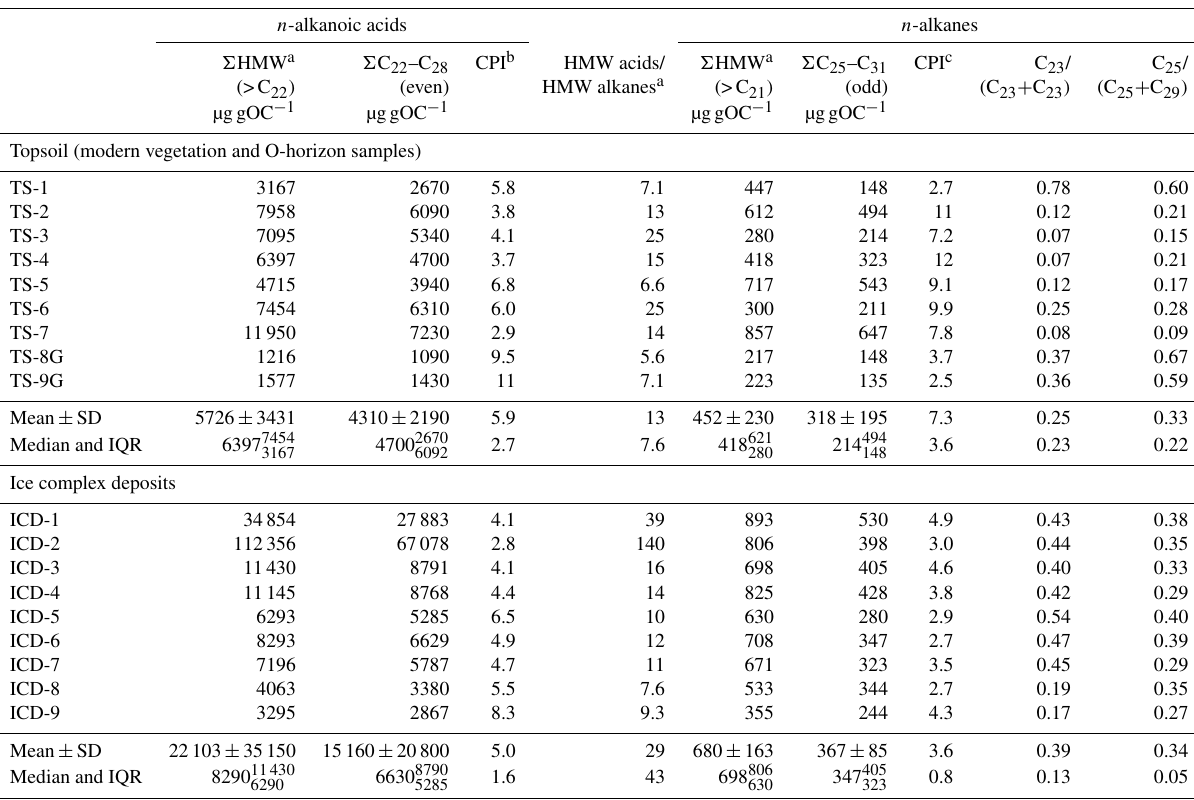
Table 4. Sum of most abundant long-chain n -alkanoic acids and n -alkanes (concentrations in µggOC − 1 ), and characteristic ratios of n - alkanoic acids and n -alkanes of topsoil Holocene (modern vegetation and O horizon) and Pleistocene ice complex samples. n -alkanoic